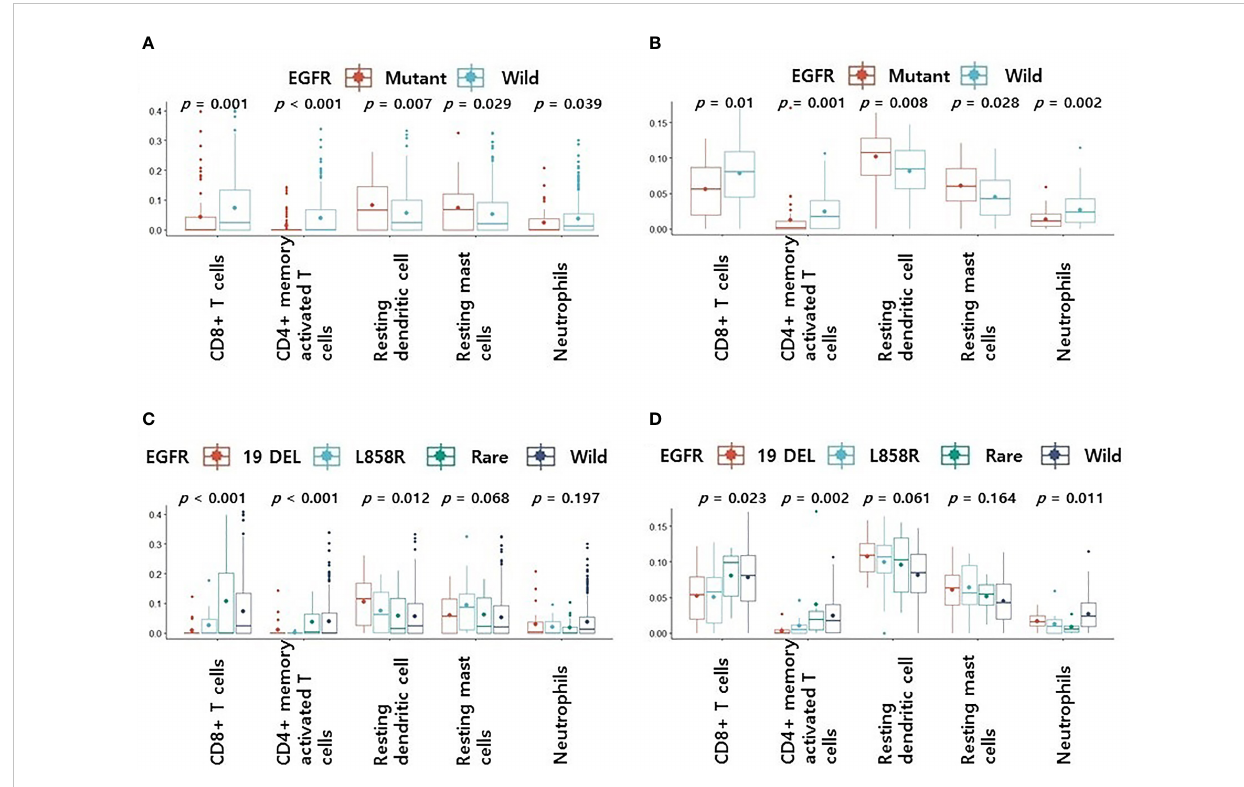
FIGURE 1 Differences in 5 immune cell components according to EGFR mutation pro fi les. (A) Changes in levels of 5 immune cell components according to EGFR mutations in pancancer dataset (A) and cptac dataset (B) . Changes in levels of CD8+ T cells, CD4 memory activated T cells, resting dendritic cells, resting mast cells and neutrophils according to EGFR mutational subtypes in pancancer dataset (C) and cptac dataset (D) . The small dot in the boxplot is the mean value. 19 DEL, exon 19